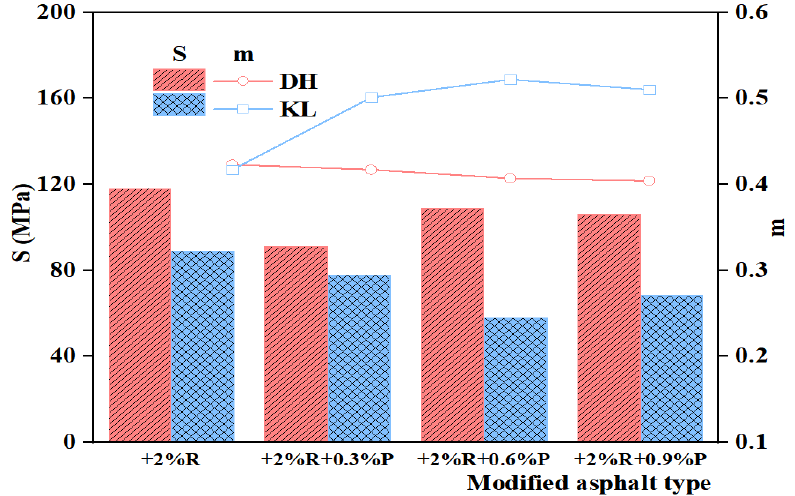
Figure 7. S and m of composite modified asphalt with different PPA dosages.